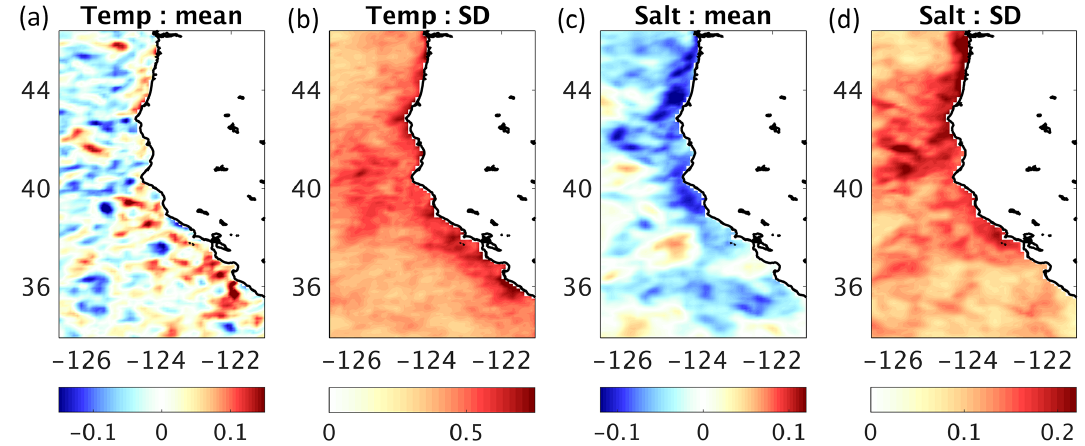
Figure 13. The mean weak minus strong constraint 4D-Var differences for (a) SST and (c) SSS for the experiment BHM estimates dur- ing 2005. The standard deviation for the (b) SST and (d) SSS weak minus constraint differences are also